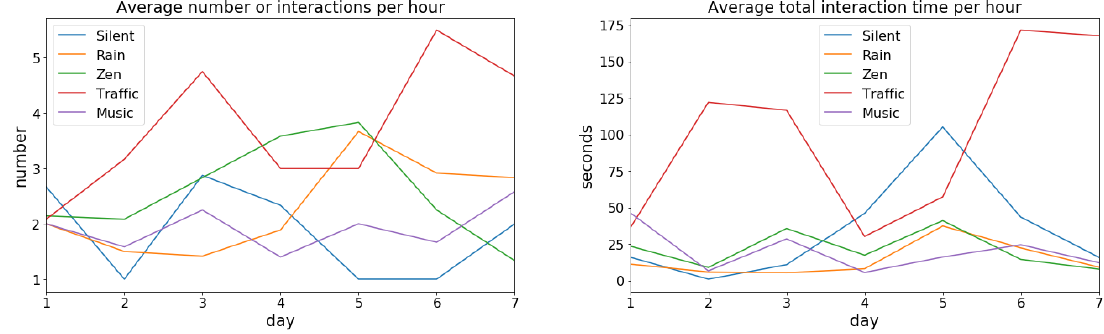
Figure 6. Daily variations in the tunnel prototype